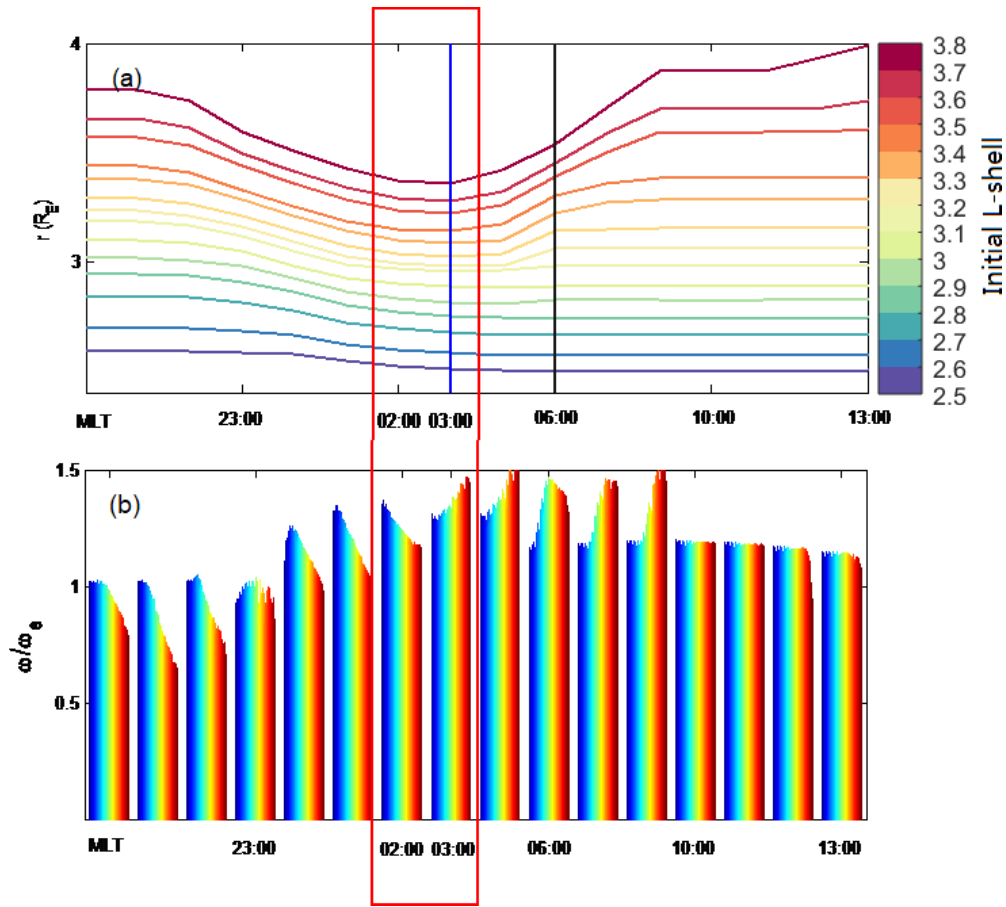
Figure 5. The trajectory (upper plot) and the rotation rate (bottom plot) of 14 test particles corresponding to MLT (location-dependent) during a substorm. The legend indicates 14 test particles of various initial L-shell. The day is 8 June